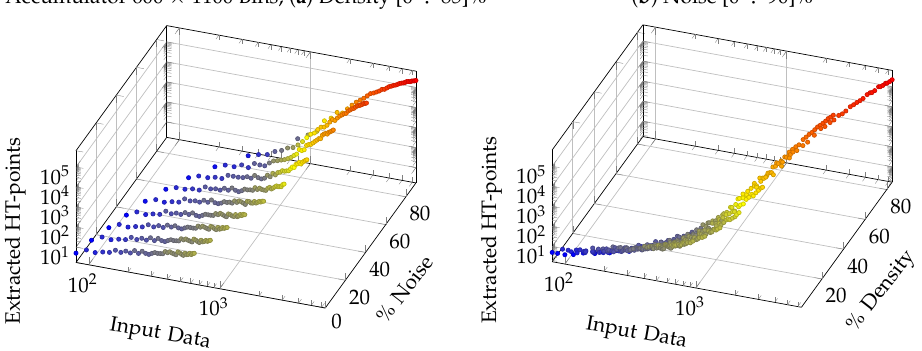
Figure 5. ( a ) HT SW noise analysis; ( b ) HT SW density